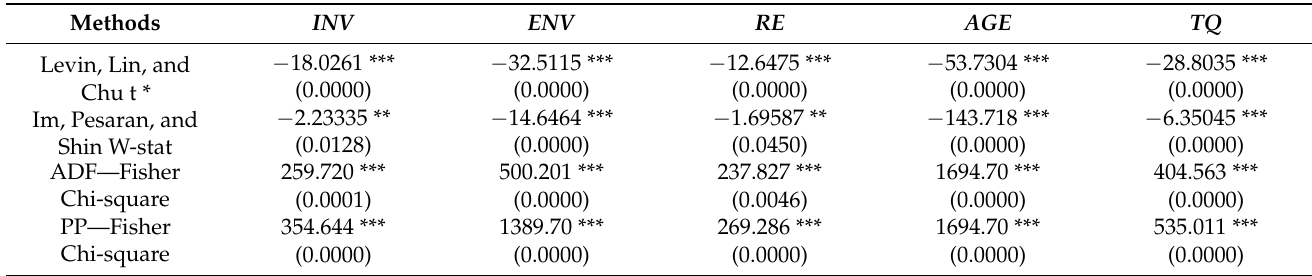
Table 3. Results of unit root test.